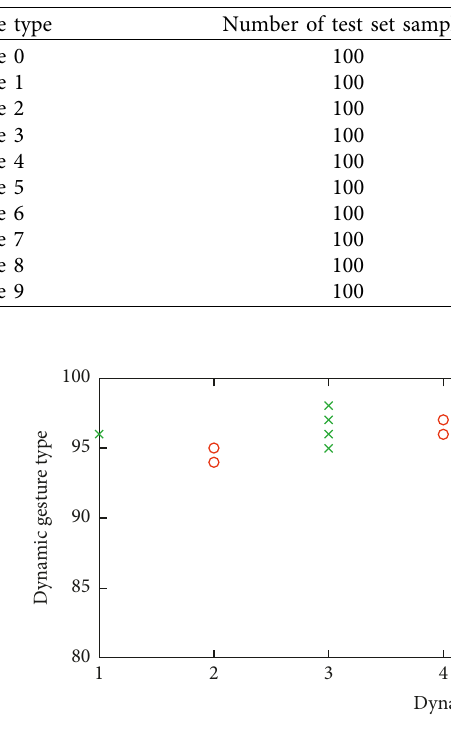
Table 3: Dynamic gesture recognition result table.